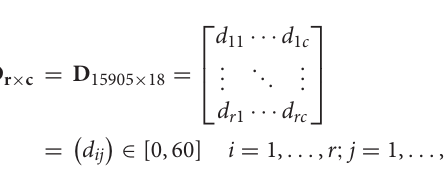
D r × c = D 15905 × 18 =